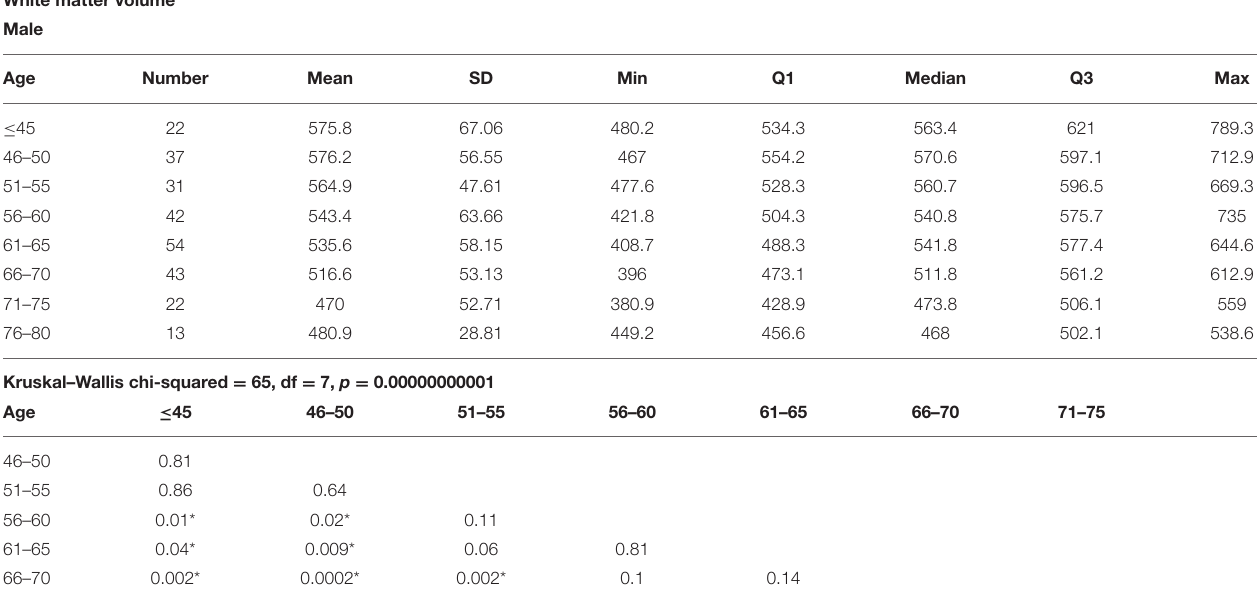
TABLE 3 | The results of total white matter measurements in different age groups and comparisons of the white matter volumes among the age groups separately in men and women. White matter